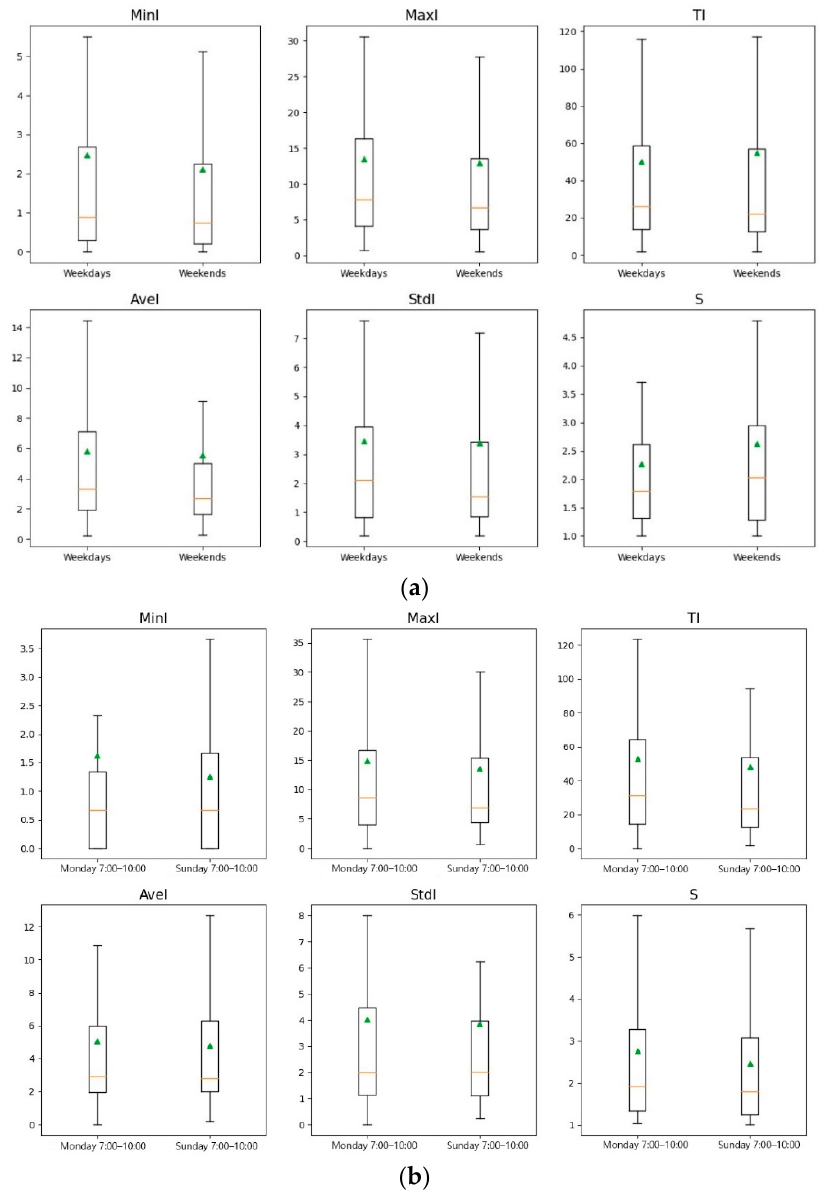
Figure 9. The statistical attributes and area of MUCs. ( a ) A comparison between weekdays and weekends; ( b ) a comparison between Monday and Sunday. The green triangle represents the mean, and the orange line represents the median.